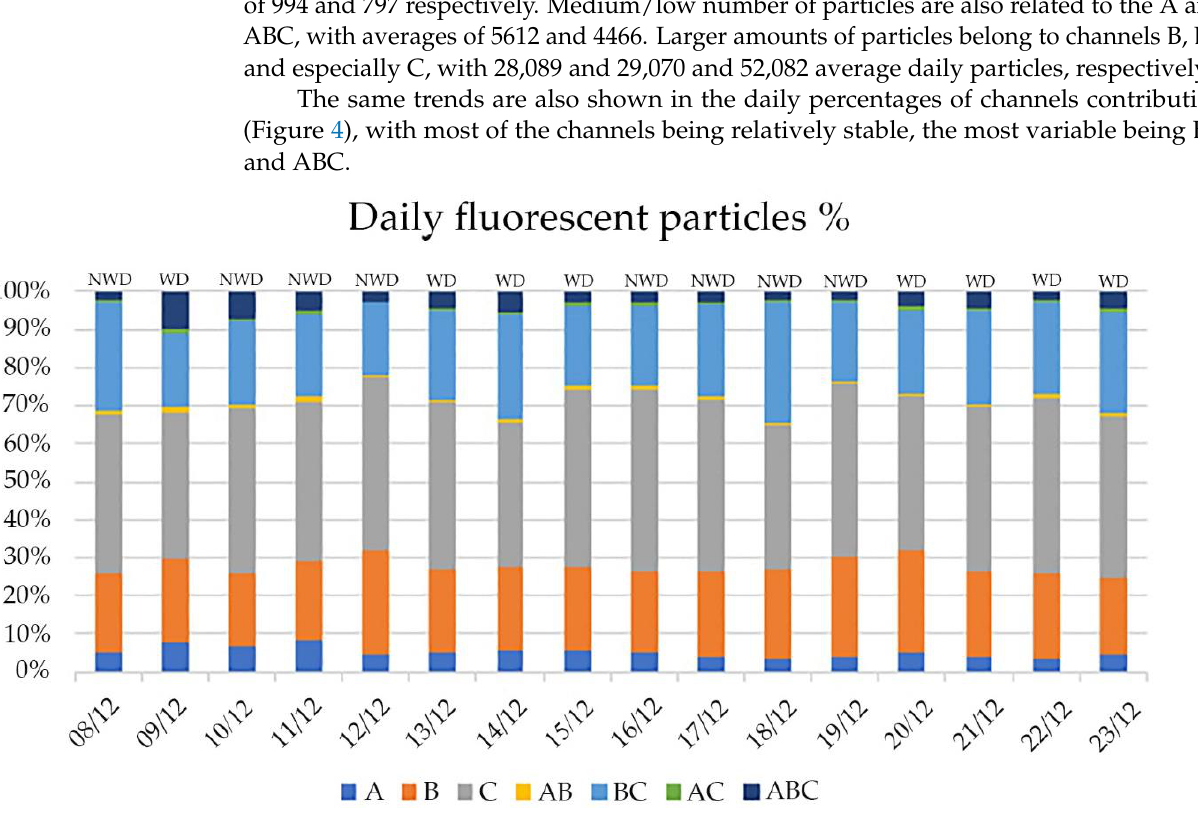
Figure 3. Number of fluorescent particles belonging to different channels (y-axis) for each day of sampling (x-axis). sampling ( x -axis).